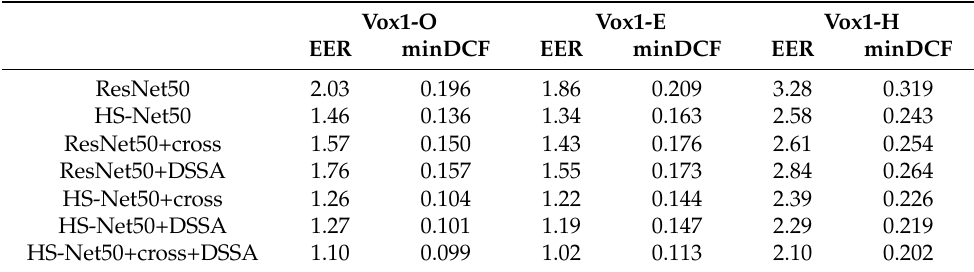
Table 2. Results of three methods and their combination on the Vox1-O/E/H.